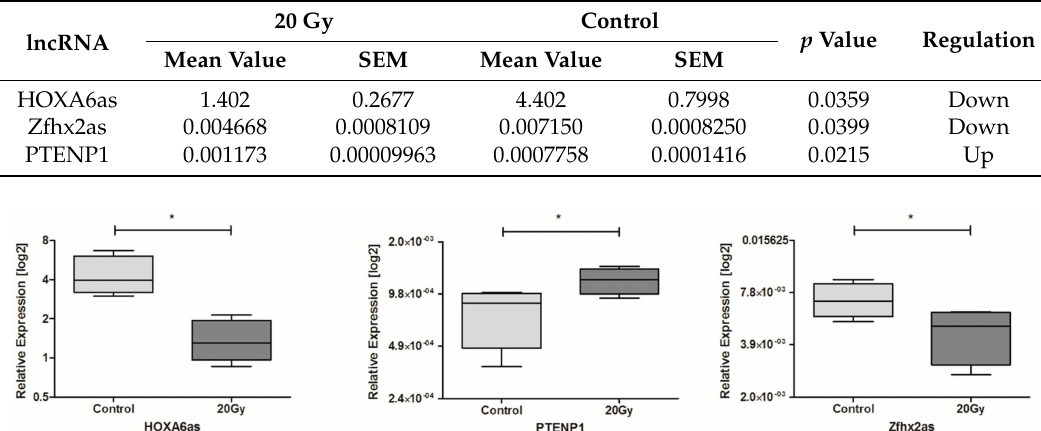
Figure 4. Differences in lncRNAs expression: HOXA6as, PTENP1, and Zfhx2as in HNSCC cell lines after exposure to 20 Gy irradiation. Paired t -test; the graphs show relative expression, mean value with SEM; * p <